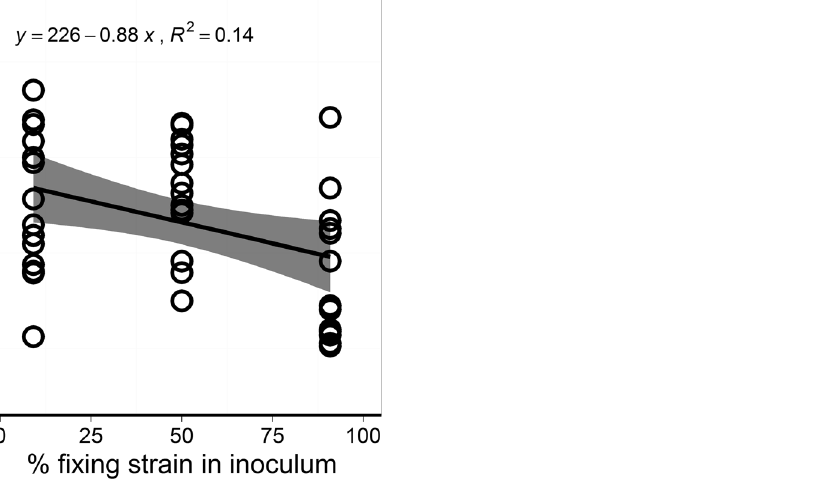
Figure 4. Total nodule number. The total number of nodules decreased as the percentage of fixing nodules increased (slope = − 0.88 ± 0.34, t 39 = − 2.565, p = 0.0143). Regression with 95% confidence interval